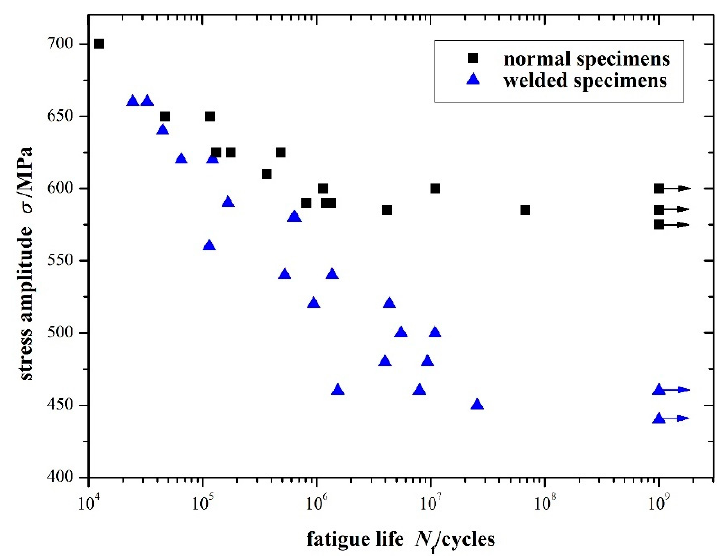
Figure 5. The very high cycle fatigue S-N curve of welded specimens.